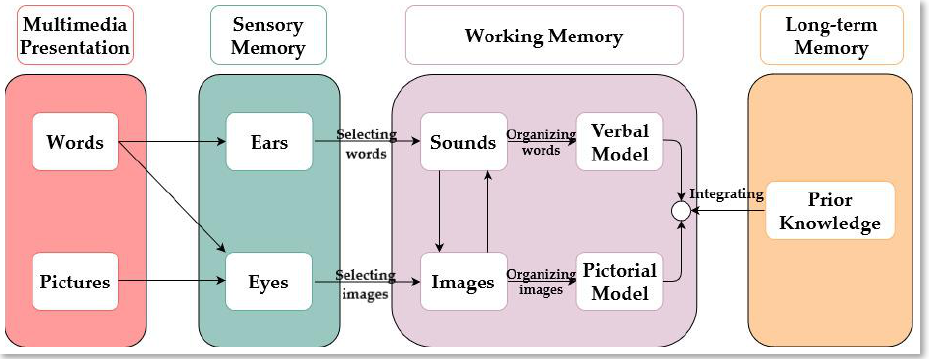
Figure 2. Mayers’ Cognitive Theory of Multimedia Learning [50] (p. 545).